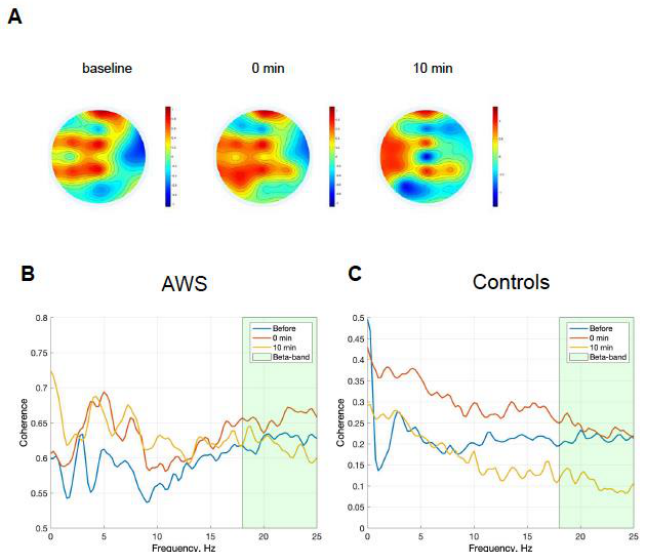
Figure 4. Topography and frequency specificity of binaural beats stimulation-induced changes. ( A ) Topographical distribution of β - power before, after, and 10 min after the stimulation. ( B ) Coherence between LTP junction and LFT area during speech in AWS before, immediately after, and 10 min after stimulation. ( C ) Coherence between LTP junction and LFT area during speech in controls before, immediately after, and 10 min after stimulation Abbreviations: AWS — adults with stuttering; LTP — left temporoparietal junction; LFT — left frontotemporal area.